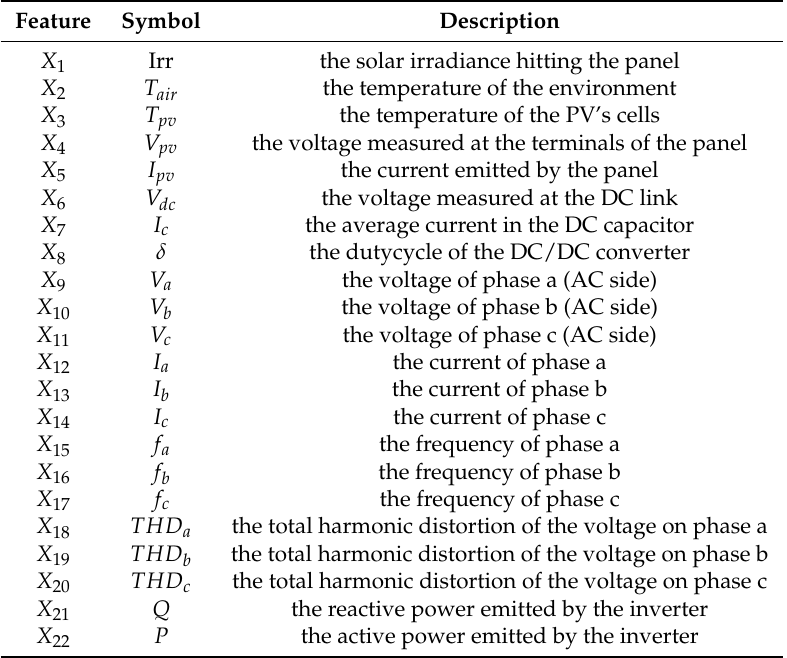
Table 1. List and description of the